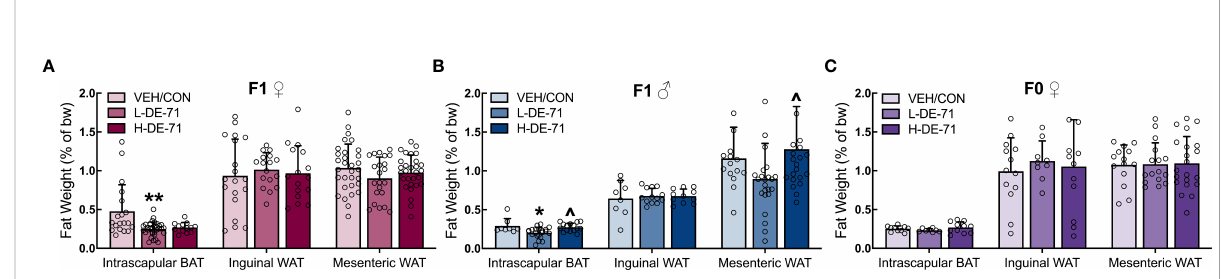
FIGURE 1 Brown adipose tissue (BAT) in DE-71-exposed male and female offspring. (A – C) Normalized weight of fat depots (WAT and BAT) were compared across treatment groups: 0.1 mg/kg/d (L-DE-71), 0.4 mg/kg/d (H-DE-71) and oil vehicle controls (VEH/CON) of female (A) , male (B) , and dams (C) . * p <0.05, ** p <0.01 compared to VEH/CON; ^ p <0.05 compared to L-DE-71. Sample size (n/group): (A) female offspring 16-31/group; (B) male offspring 8-24/group; (C) dams 8-21/group. Bars and error bars represent mean±s.e.m. BAT, brown adipose tissue. WAT, white adipose tissue [ Permission obtained for reuse of left panel in Figure 2A and left panel in 2C, Kozlova et al, 2020, Sci. Rep. 10:18102]